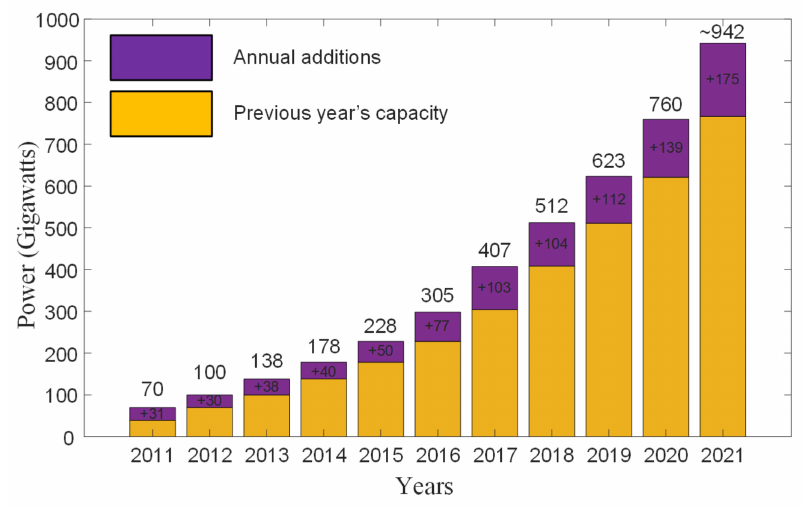
Figure 1. Solar PV global capacity and annual additions, 2011–2021 [3].